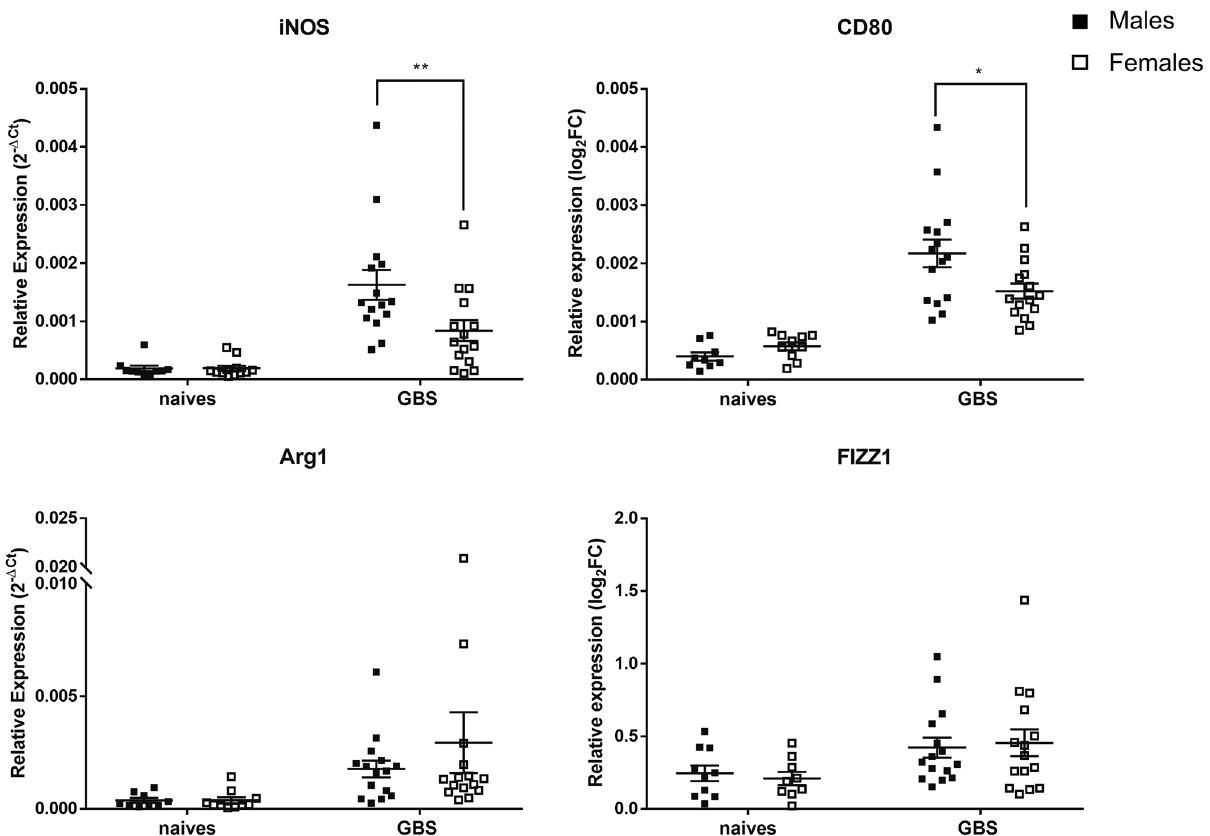
Figure 4. Sex-based assessment of iNOS and CD80 (M1) and, Arg1 and FIZZ1 (M2) expression in the lungs of GBS-infected mice (24 h pi). C57BL/6 male (black) and female (white) mice were infected intranasally with ± 10 8 CFUs of GBS (n = 15/group). Relative mRNA transcripts of iNOS, CD80, Arg1 and FIZZ1 were evaluated 24 h pi in the lungs using real-time RT-PCR. The values were normalized with two internal controls, RPL-19 and β-actin. Relative expression results were compared to those obtained for uninfected male (n = 10) and female (n = 10) control mice. *p < 0.05, **p < 0.01 (Mann–Whitney U test). Data are representative of three independent